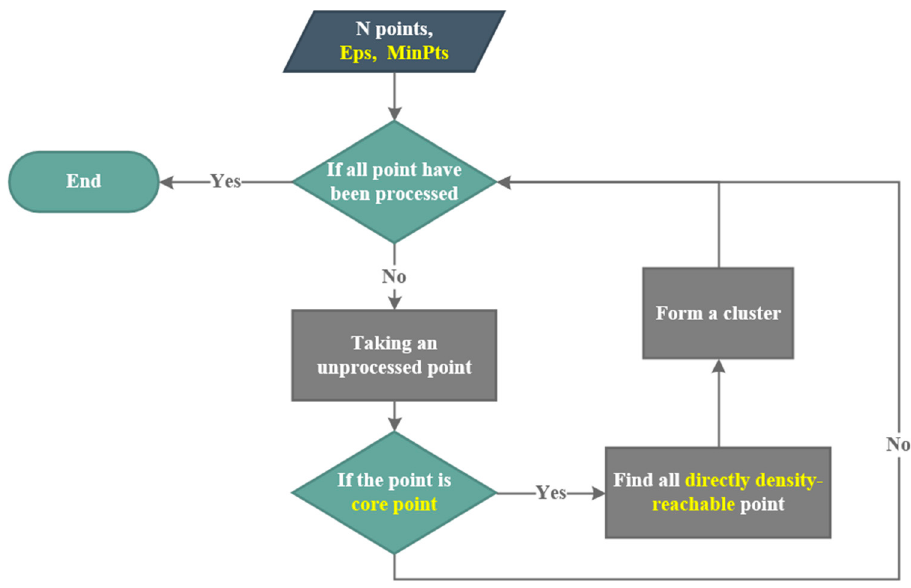
Figure 4. The detailed algorithm processing workflow for the density based clustering algorithms.